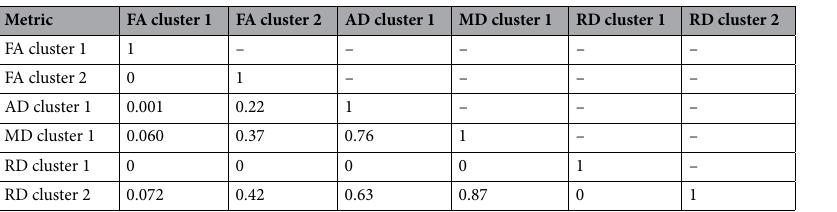
of the neurocognitive variables. Specifically, LTS parameter was significantly associated with both FA clusters (FA Cluster 1—r = 0.33, p = 0.047; FA Cluster 2—r = 0.39, p = 0.020), AD cluster (r = -0.42, p = 0.010), RD cluster